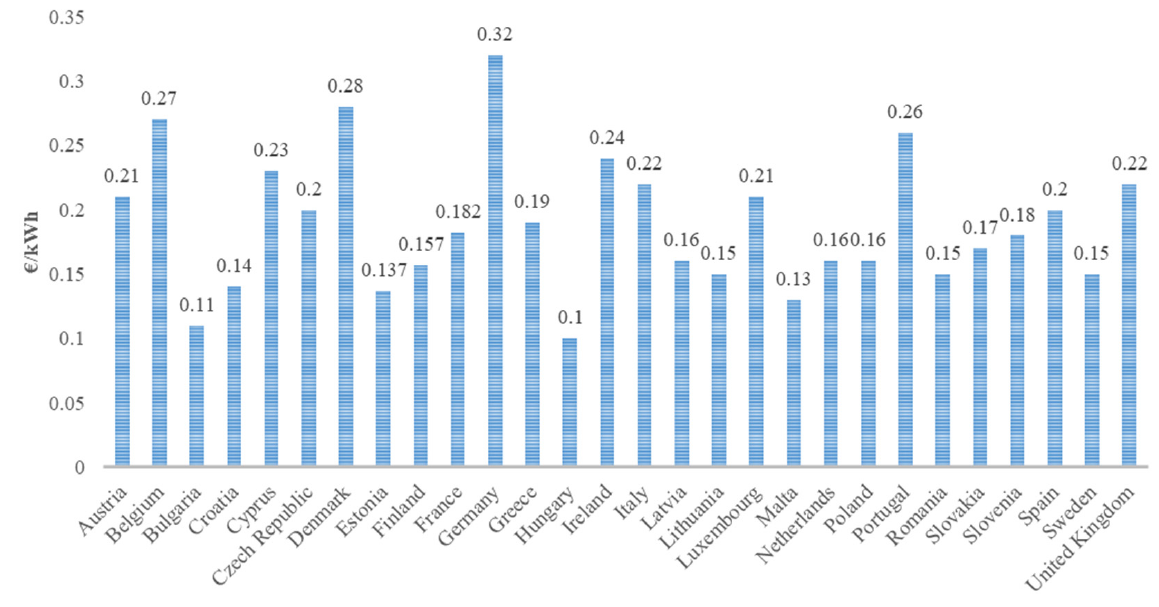
Figure 1. Electricity price for EU residential users (based on [2]).